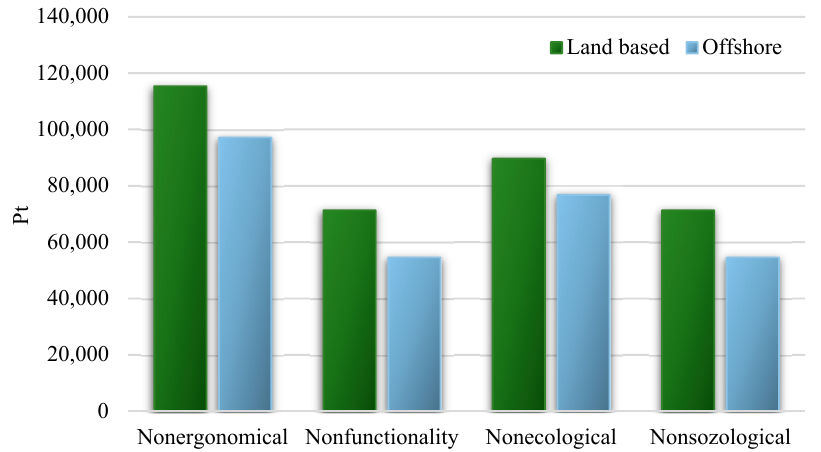
Figure 8. Results of grouping and weighing environmental effects for types of impacts, occurring in life cycles of land-based and offshore wind power plants. Authors’ own research.